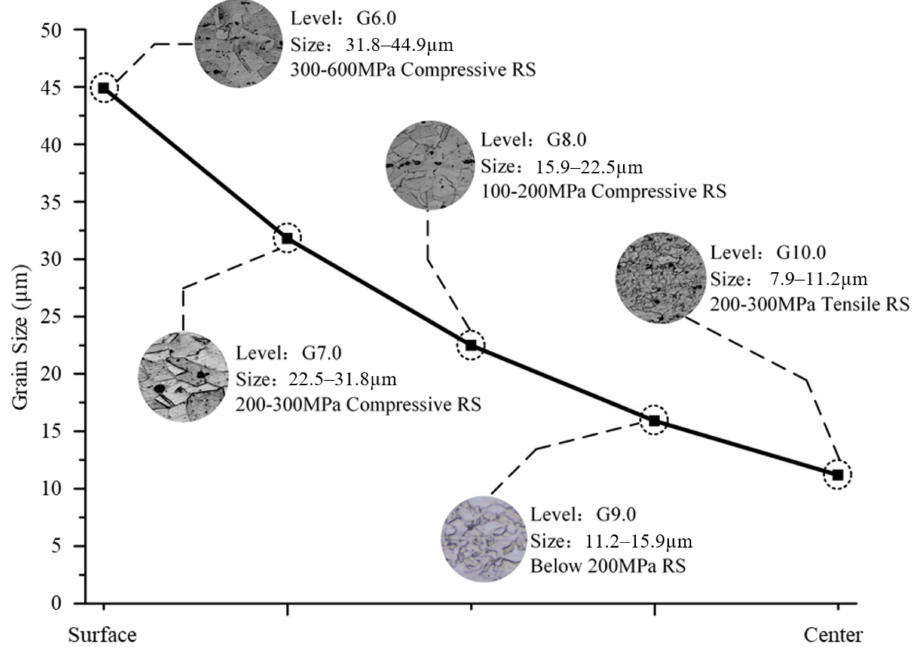
Figure 19. Residual stress division based on grain